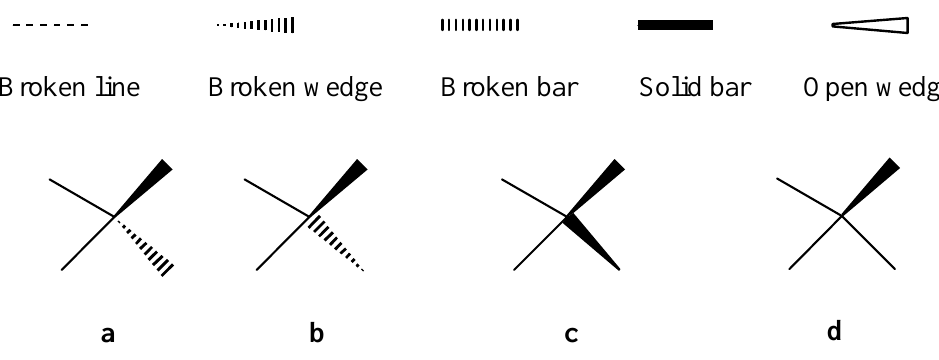
Figure 2. One-wedge convention for stereochemical